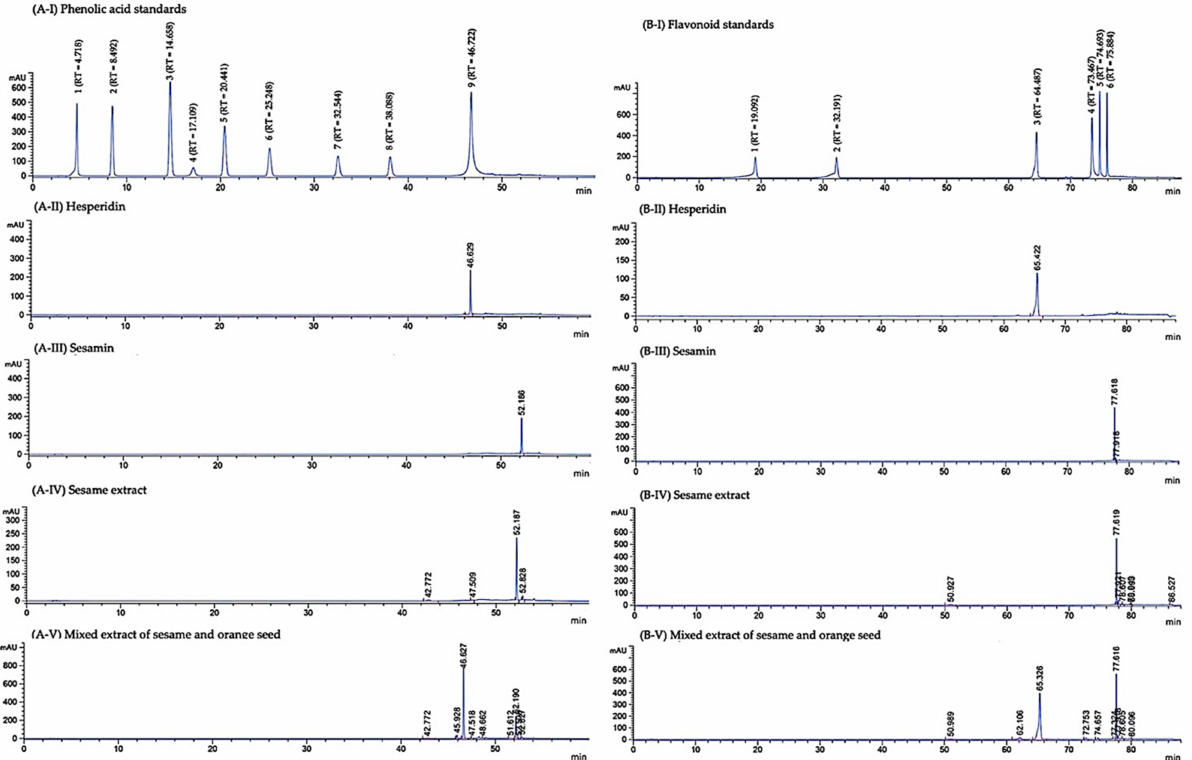
Figure 3. HPLC chromatograms of phenolic acids ( A ) and flavonoids ( B ) of standard hesperidin and sesamin, sesame extract and mixed extract of sesame and orange seed. Gallic acid (1), Protocatechuic acid (2), 4-hydroxybenzoic acid (3), Chlorogenic acid (4), Vanillic acid (5), Syringic acid (6), p-Coumaric acid (7), Ferulic acid (8) and Ellagic acid (9) were used as phenolic acid standards. The standard flavonoids were Catechin (1), Epicatechin (2), Rutin (3), Quercetin (4), Luteolin (5) and Apigenin